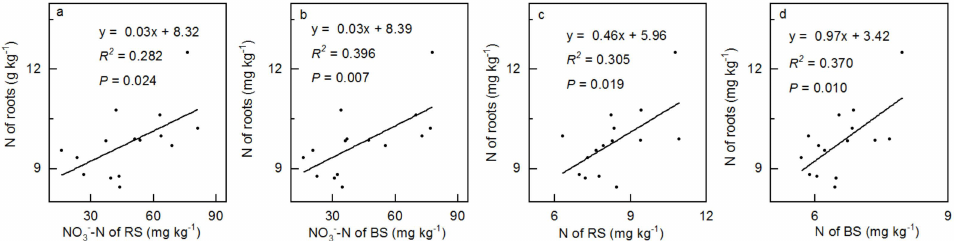
Figure 6. Correlations between soil (rhizosphere and bulk, x) and roots (y) nutrients. Correlation of rhizosphere soil NO 3 − -N and roots N ( a ), bulk soil NO 3 − -N and roots N ( b ), rhizosphere soil N and roots N ( c ) and bulk soil N and roots N ( d